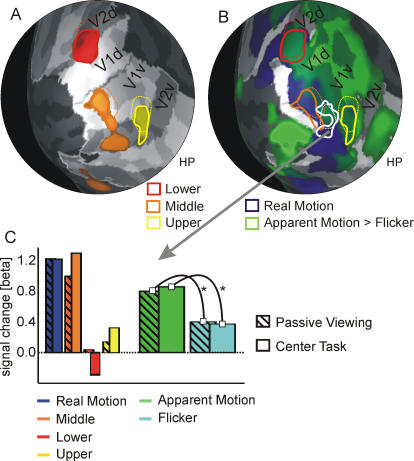
Cortical Activation in V1 for Experiment 2(A) Left occipital cortex of subject HP (all five subjects are shown in Figure S2) with superimposed contrast maps indicating the cortical representation of the stimulus positions: upper (yellow), t(1445) > 15; middle (orange), t(1445) > 12; and lower (red), t(1445) > 9.3 (all p << 0.001). For comparison, the patches from experiment 1 (see Figure 1) are marked with dotted lines.(B) Cortical activation maps for apparent motion (green) and real motion (blue). In this case, apparent motion is contrasted with the flicker control condition (apparent motion > flicker in V1: t[1445] > 3.6, p < 0.0004); real motion is compared to fixation baseline (real motion > baseline in V1: t[1445] > 18.6, p << 0.001). The white line indicates an example of a significant (t > 2.2, p < 0.05) contrast conjunction: (middle > upper) and (middle > lower) and (apparent motion > flicker).(C) BOLD activity profile of the region indicated by the white line in (B). Bars indicate average activity during the respective conditions expressed in beta weights from a GLM analysis.